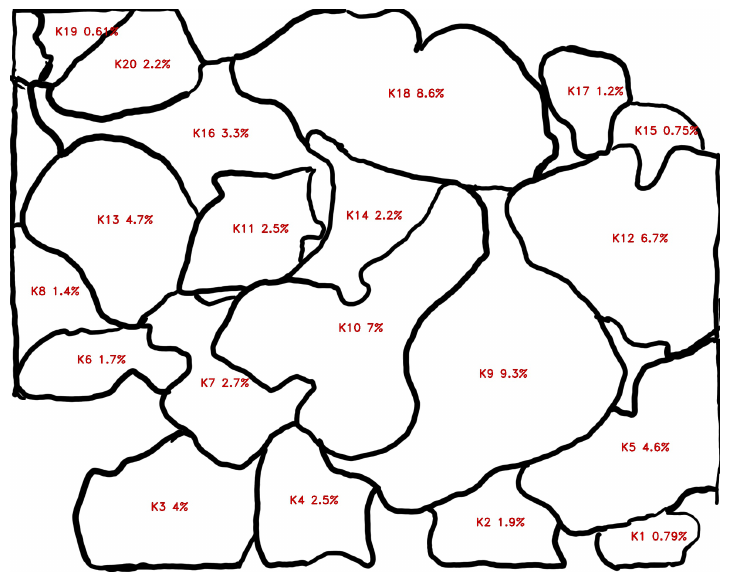
Figure 9. Simple contour detection benchmark.